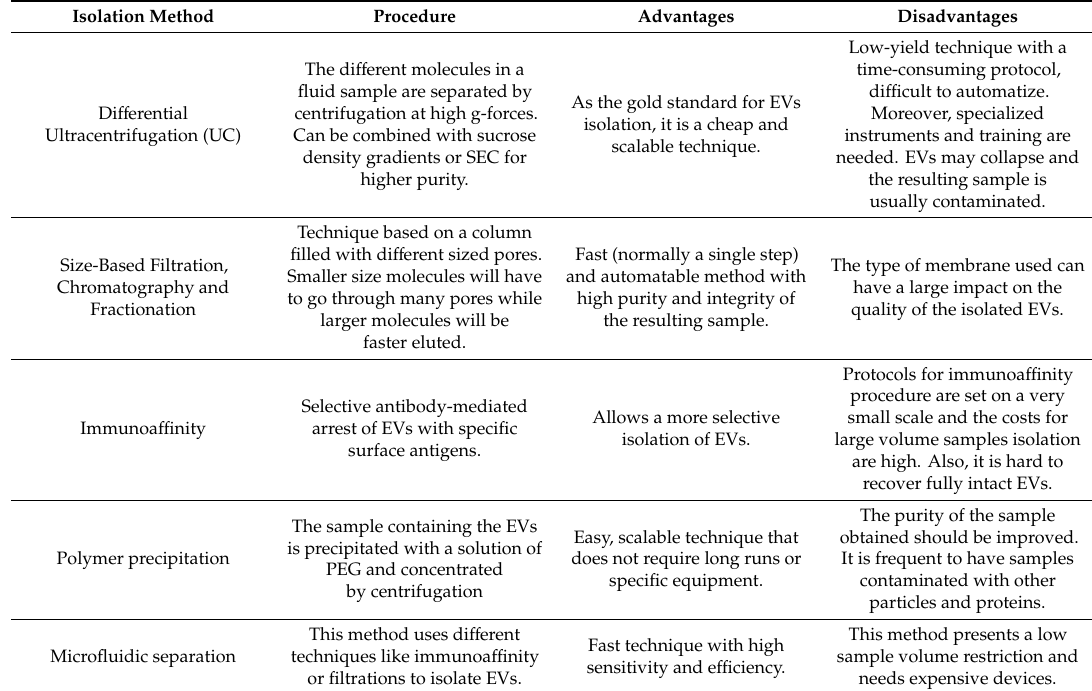
Table 1. Extracellular vesicle (EV) isolation